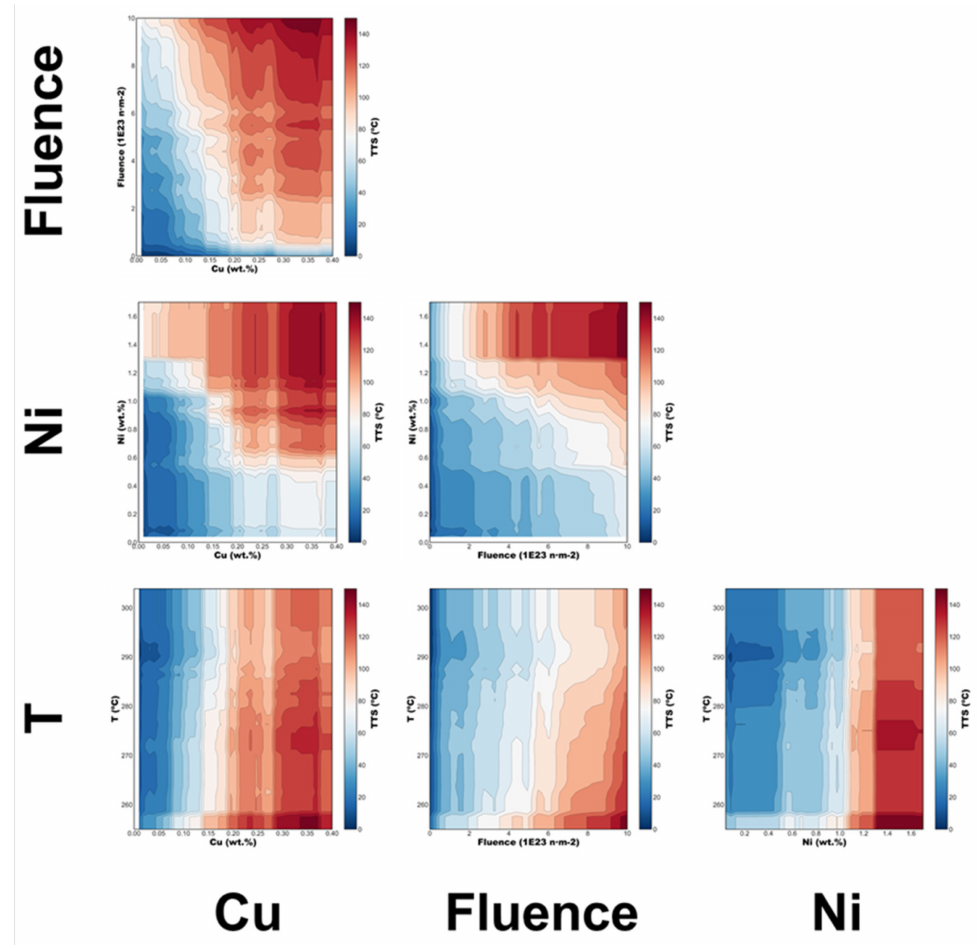
Figure 12. 2D Interaction plots between the four most relevant features: Cu, fluence, Ni and T.